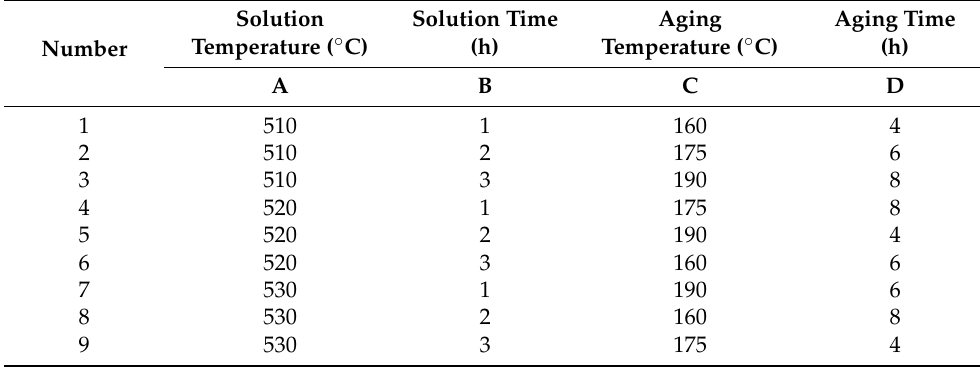
Table 2. Scheme and results of the orthogonal test (L 9 (3 4 )).